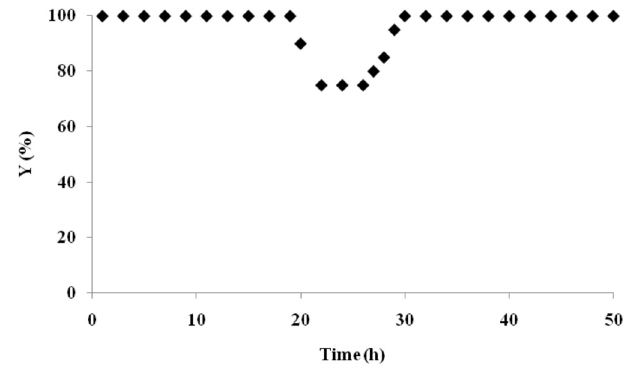
FIGURE 4 - Variation in conversion during continuous sucrose hydrolysis catalyzed by immobilized invertase for test 13: [Sucrose] = 50 mM (time interval: 0-20h) and [Sucrose] = 100 mM (time interval: